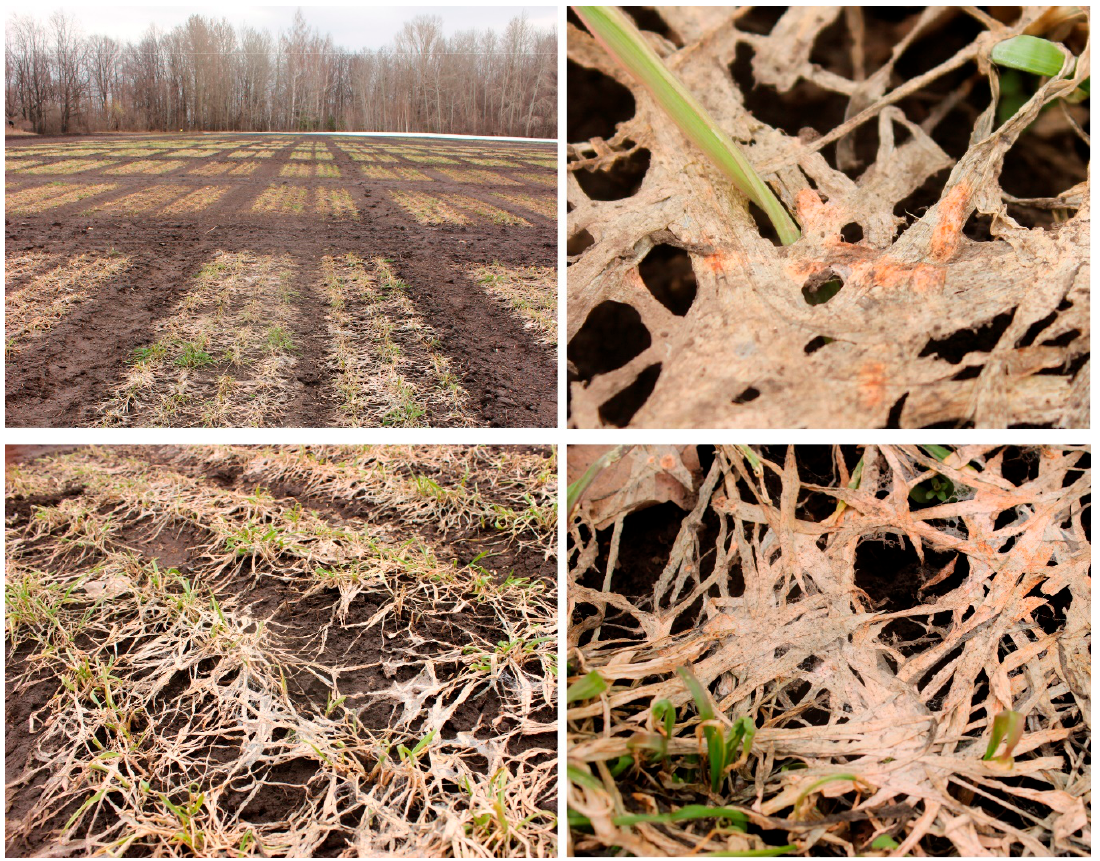
Figure 1. Snow mold-damaged winter rye plants (Tatarstan, Russia, 2019).